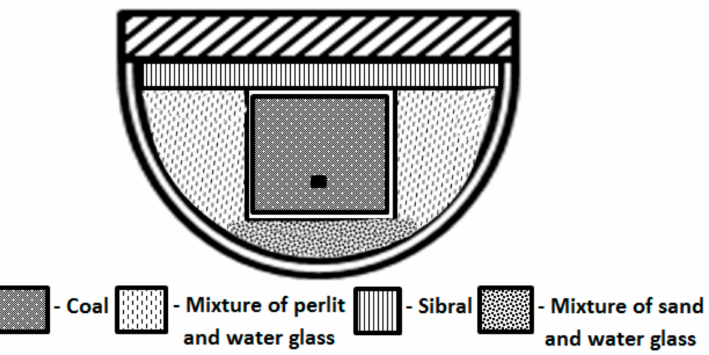
Figure 3. The cross-sectional designs of the coal model for the first experiment (Source: own elaboration based on [36]).